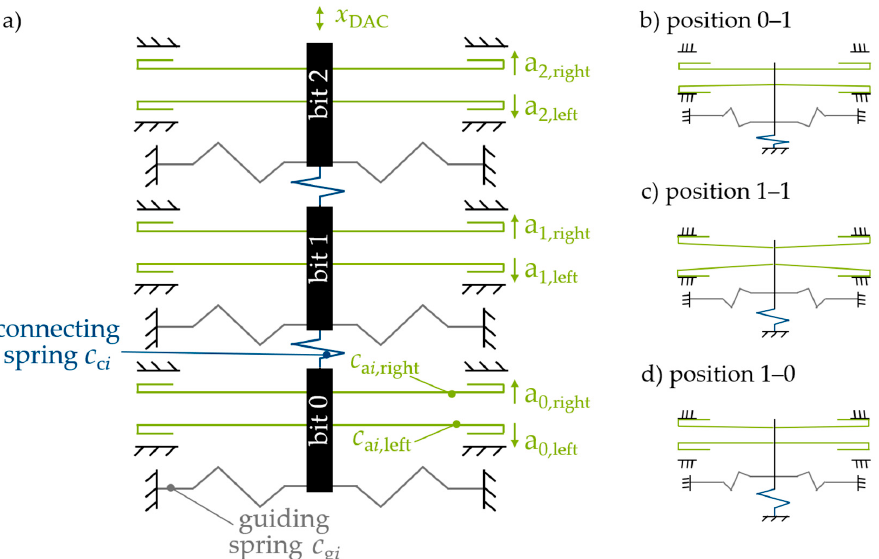
Figure 11. ( a ) Setup of a 3-bit DAC; a single bit in ( b ) position 0–1, ( c ) position 1–1, ( d ) position 1–0, adapted from © [2023] IEEE. Reprinted, with permission, from [L. Schmitt, X. Liu, A. Czylwik and M. Hoffmann, “Large Displacement Actuators with Multi-Point Stability for a MEMS-Driven THz Beam Steering Concept,” Journal of Microelectromechanical Systems, 2023], [52].